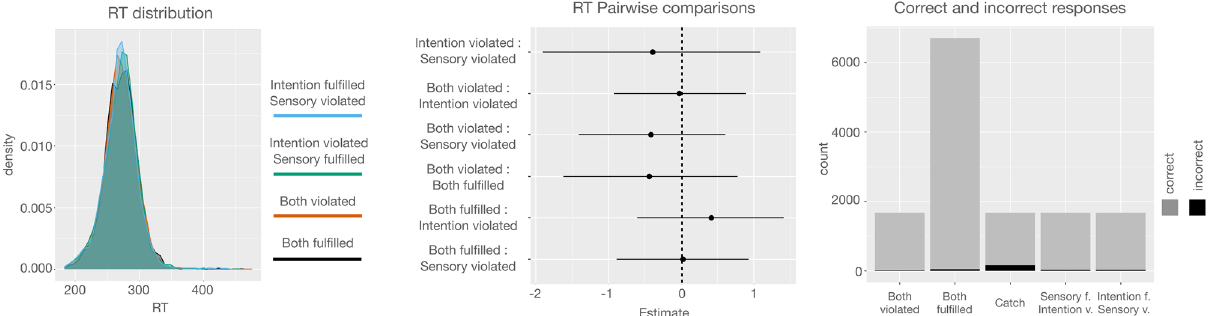
Figure 2. Behavioural results. Left panel shows the distribution of RTs per condition. Central panel illustrates the RT pairwise comparisons. No significant differences were observed. Right panel shows the rate of correct and incorrect responses per condition. Results indicate that participants correctly followed the instructions throughout the task. The low rate of incorrect responses in the catch trials indicates that participants were able to correctly identify the two possible two sequences.